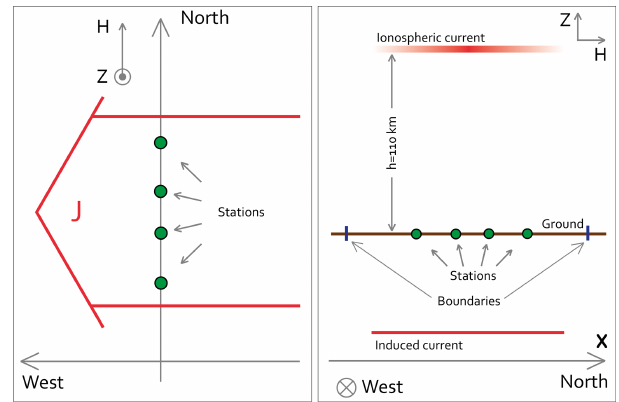
Figure 3. The model